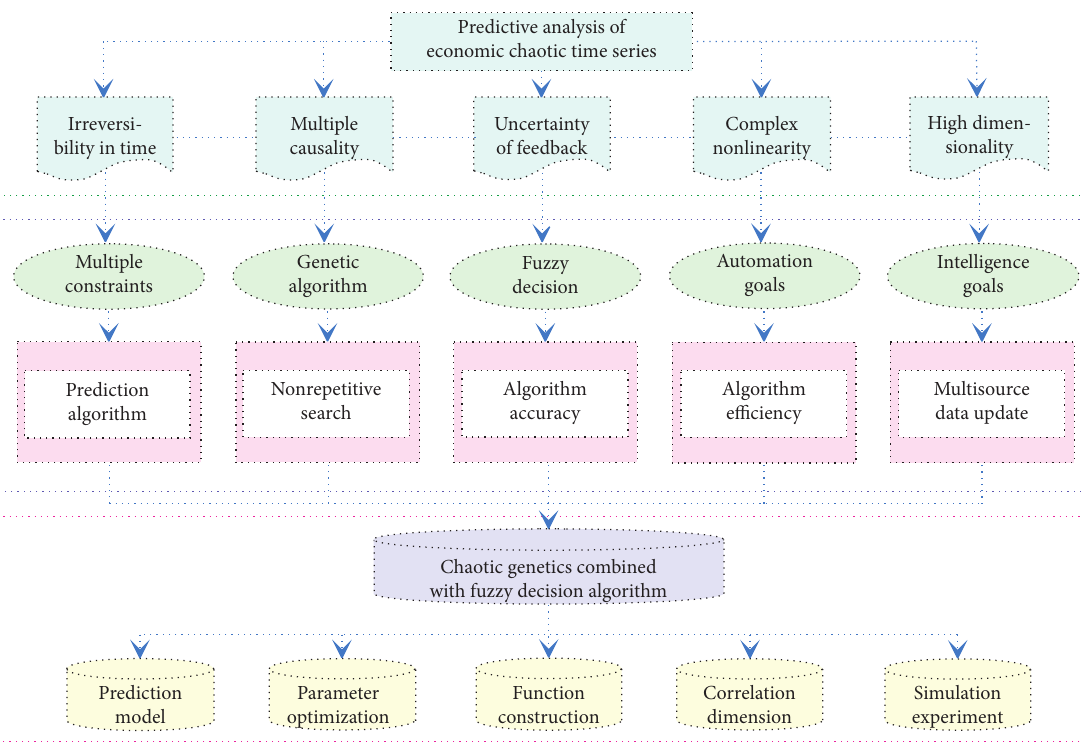
Figure 1: Analytical framework of economic chaotic time series prediction based on chaotic genetics combined with fuzzy decision